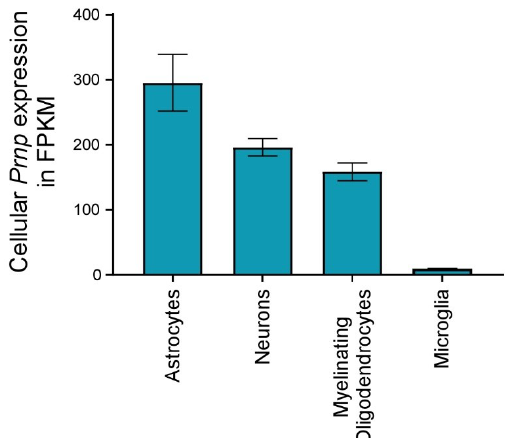
Figure 6. Cellular Prnp expression by various brain cells in healthy mice. RNA seq data of purified cells isolated from health mouse brain was acquired from the work of Zhang et al. and represented here in fragments per kilobase million (FPKM) for comparison [165]. The blue columns are the average of two replicates of pooled animals for each cell type and bars represent the standard deviation. Astrocytes express the most Prnp , while microglia express very